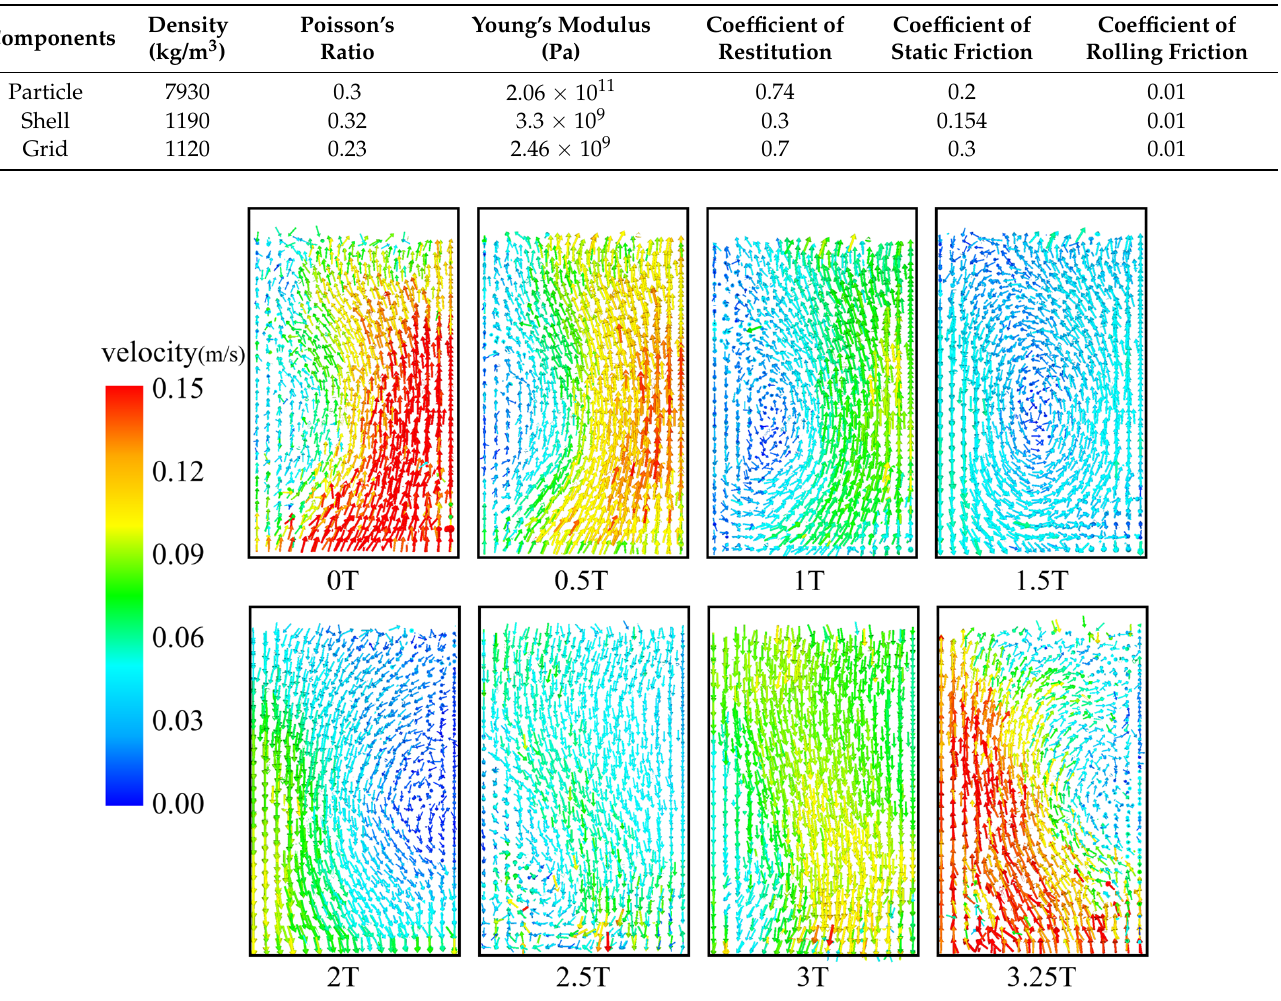
Figure 10. Particle motion in a particle damper without grid.